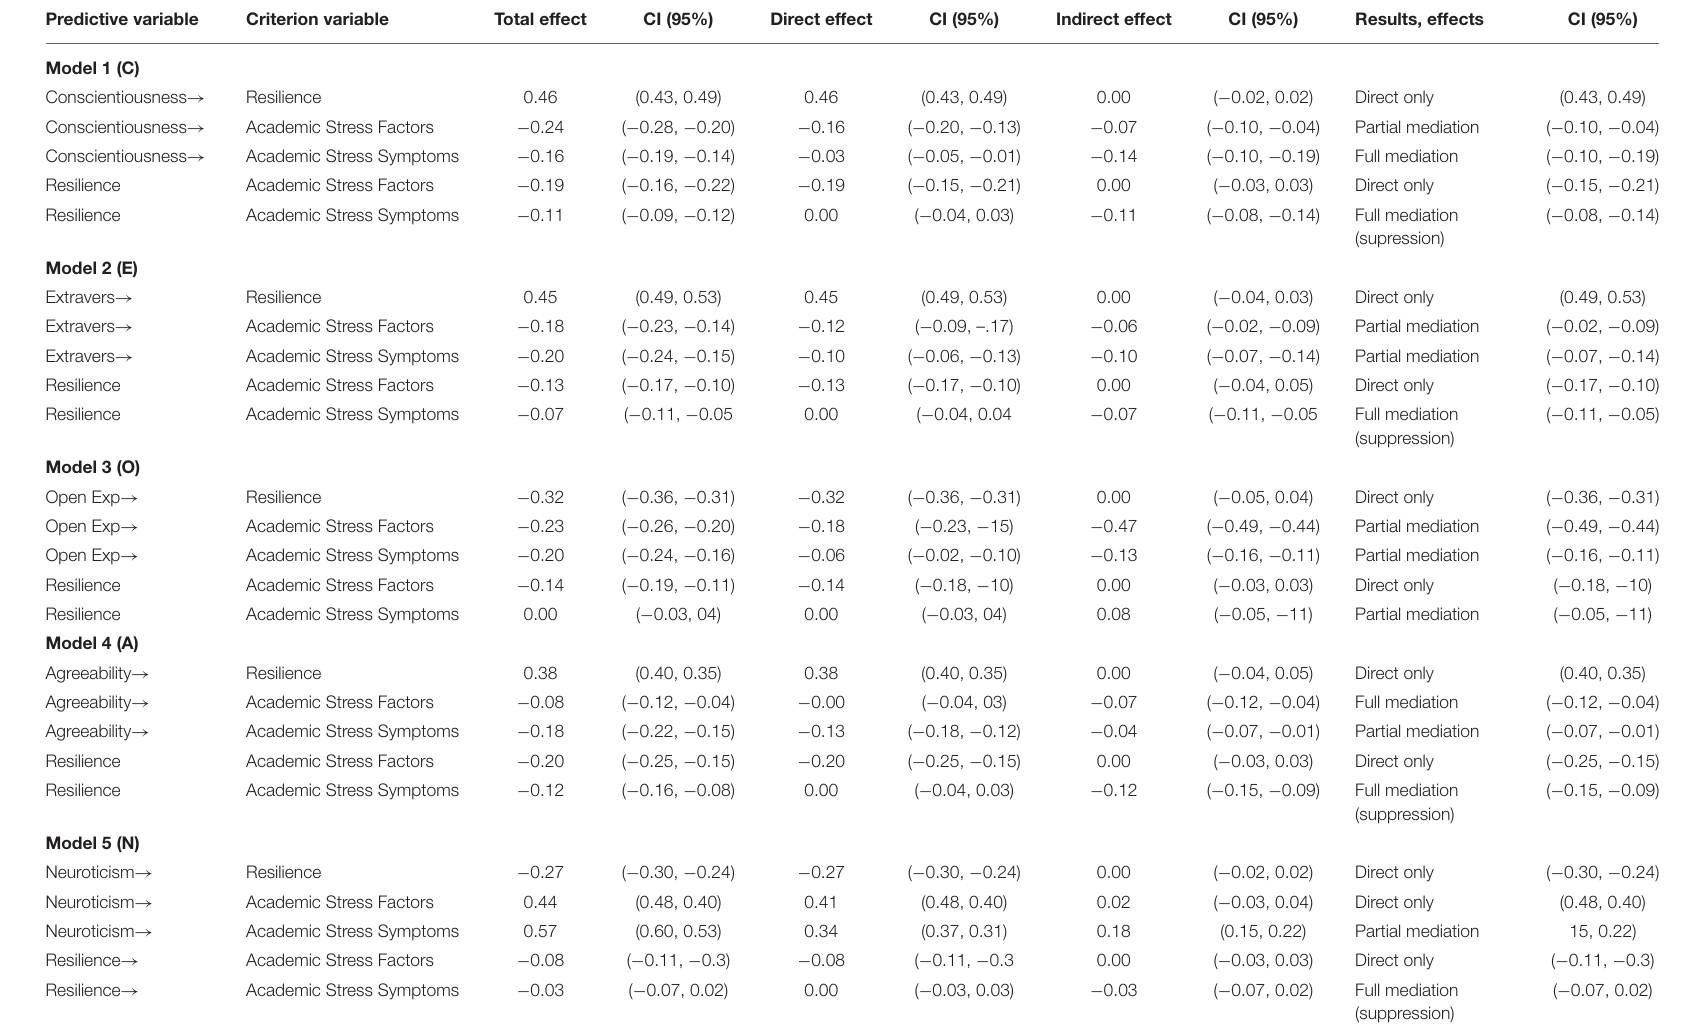
TABLE 11 | Total, indirect, and direct effects of the variables in this study, and 95% bootstrap confidence intervals